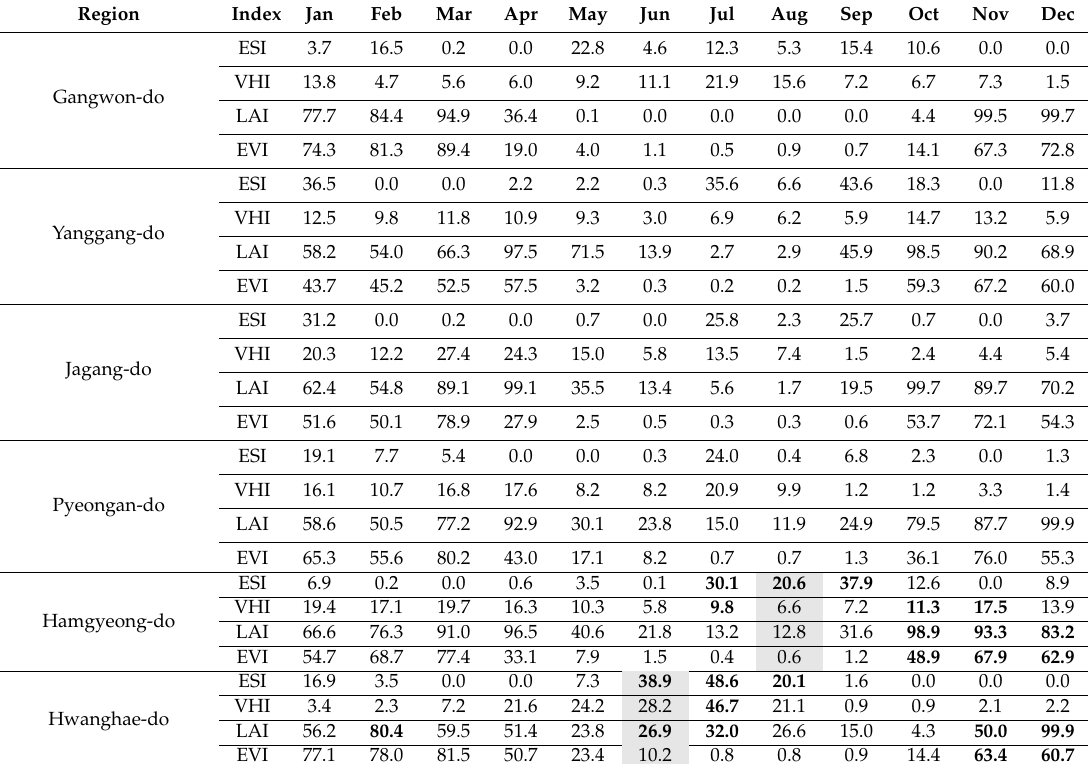
Table 3. Comparison of drought rate by region and actual drought periods, North Korea, 2017 (%). Region Index Jan